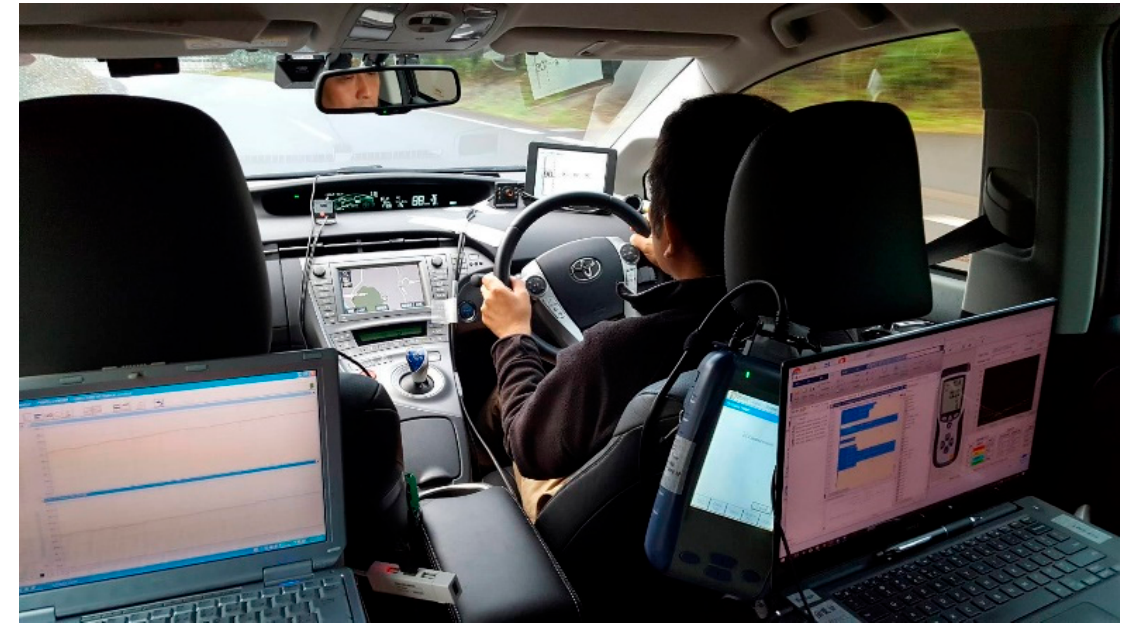
Figure 1. Analytical experiment on third-generation Prius (Prius3) at Japanese Automobile Research Institute (JARI) Shirosato.